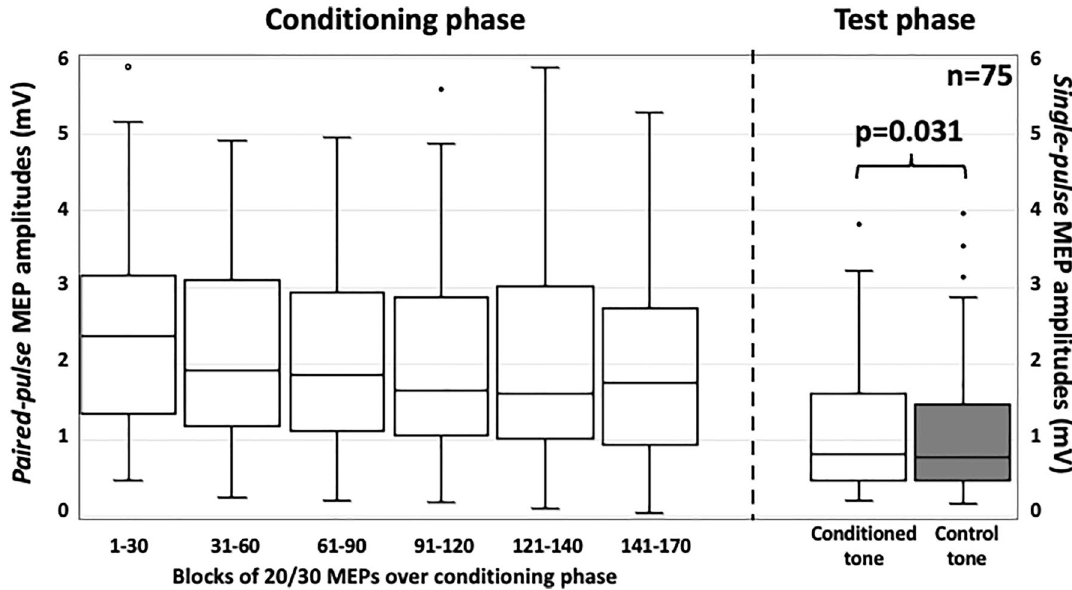
Figure 2. MEP amplitudes (in mV) over the conditioning phase (left boxes) and the test phase (right boxes). Conditioning phase: median MEP amplitudes (grouped in blocks of 20–30 trials) showed no significant shifts over the course of conditioning (Kruskal–Wallis test, chi-square = 0.67, df = 5, p = 0.123, eta 2 = 0.024). Test phase: MEP amplitudes of single TMS pulses paired with the conditioned tone were significantly higher than for the control tone (n = 75, Wilcoxon-Signed Rank, z = − 2.15, p = 0.031, r = − 0.248; 55% responder), suggesting successful conditioning of TMS-induced intracortical facilitation. The top of each box indicates the 1st quartile, the bottom the 3rd quartile. The horizontal line within the box marks the median, whiskers indicate minimum and maximum, dots